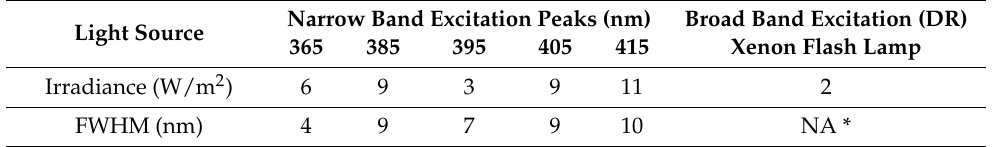
Table 1. Mean values ( n = 5) of irradiance and full width at half maximum (FWHM) measured at